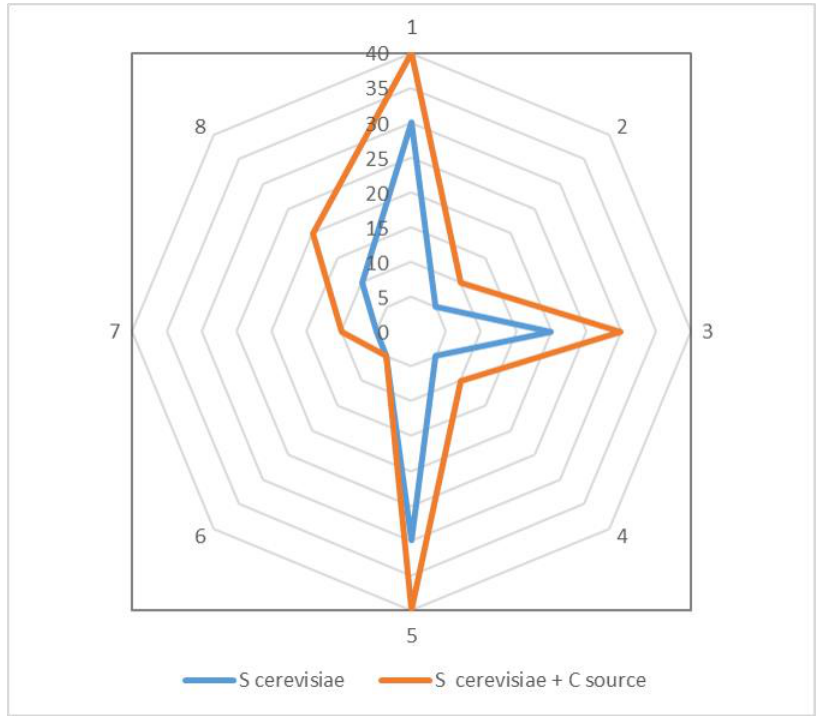
FIGURE 6: Enzymatic profiles of S. cere- visiae yeast cells at the end of dry bio- cleaning process (18 hours) on-site at The Four Fountains , in the presence and ab- sence of a carbon source (Mean of two replicates). Key: 1. Alkaline phosphatase; 2. Esterase (C4); 3. Leucine arylamidase;